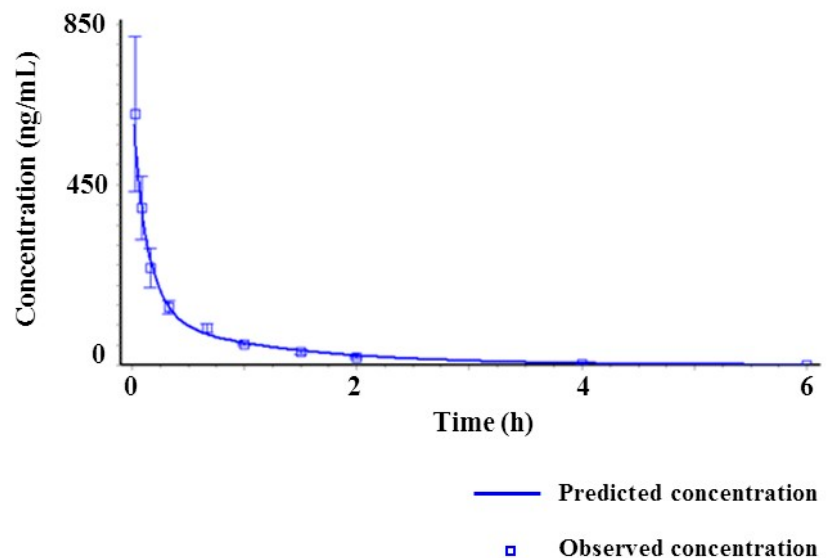
Figure 5. The simulated two-compartment model of SCH 58261 after IV administration using GastroPlus ™ , the predicted and observed time concentration profiles.